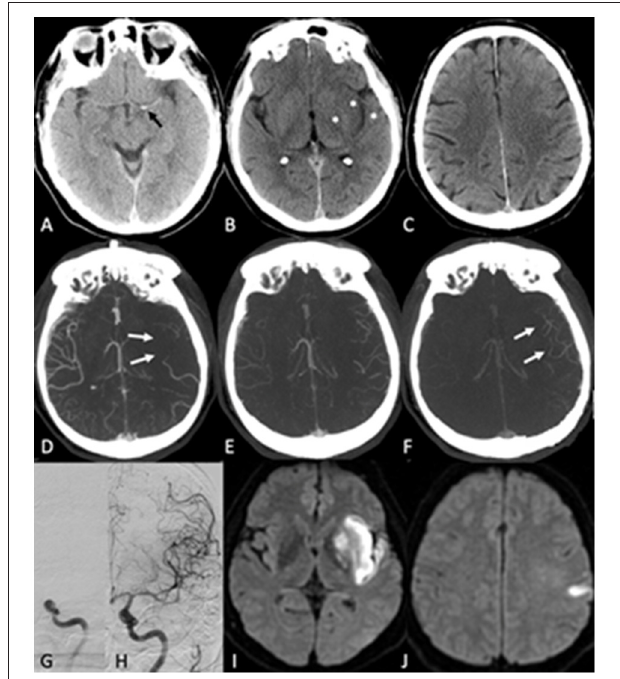
FIGURE 1 | Acute ischemic stroke due to a terminal internal carotid artery occlusion. (A,B) show the initial Plain CT. A hyperdense vessel sign [black arrow in (A) ] is seen, and there is loss of gray-white matter differentiation in the left insula, lentiform nucleus and M2 region [asterisks in (B) ], corresponding to an ASPECTS score of 7. No ischemic changes are seen at the supraganglionic level (C) . Multiphase CTA shows lack of collateral filling in the first (arterial) phase [white arrows in (D) ]. However, the pial arterial collaterals fill eventually in the second (peak-venous) phase (E) . There is a slight delay in washout in the third phase (F) . Intravenous thrombolysis was administered between Plain CT and mCTA, and the patient was treated with EVT after mCTA has been completed. (G) shows the initial digital subtraction angiography run with the occlusion. (H) shows the last intracranial angiography run with complete recanalization [modified thrombolysis in cerebral infarction (mTICI 3)]. On follow-up diffusion-weighted MRI at 24h, an infarct of moderate size in the left insula, lentiform nucleus, and M2 region was seen (I) , corresponding to the areas with early ischemic changes in the initial plain CT. There was also a small infarct in the left M5 region (J) that was not noted on the baseline plain